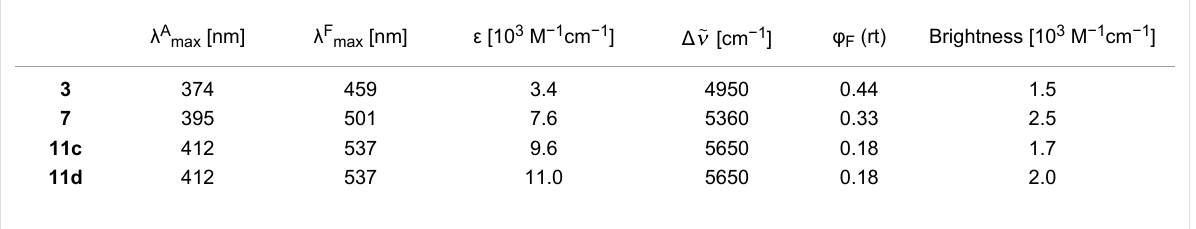
Table 1: Spectroscopic data of synthesized fatty acids in THF at room temperature. Attenuation coefficients ε refer to the longest wavelength absorp- tion peaks respectively.